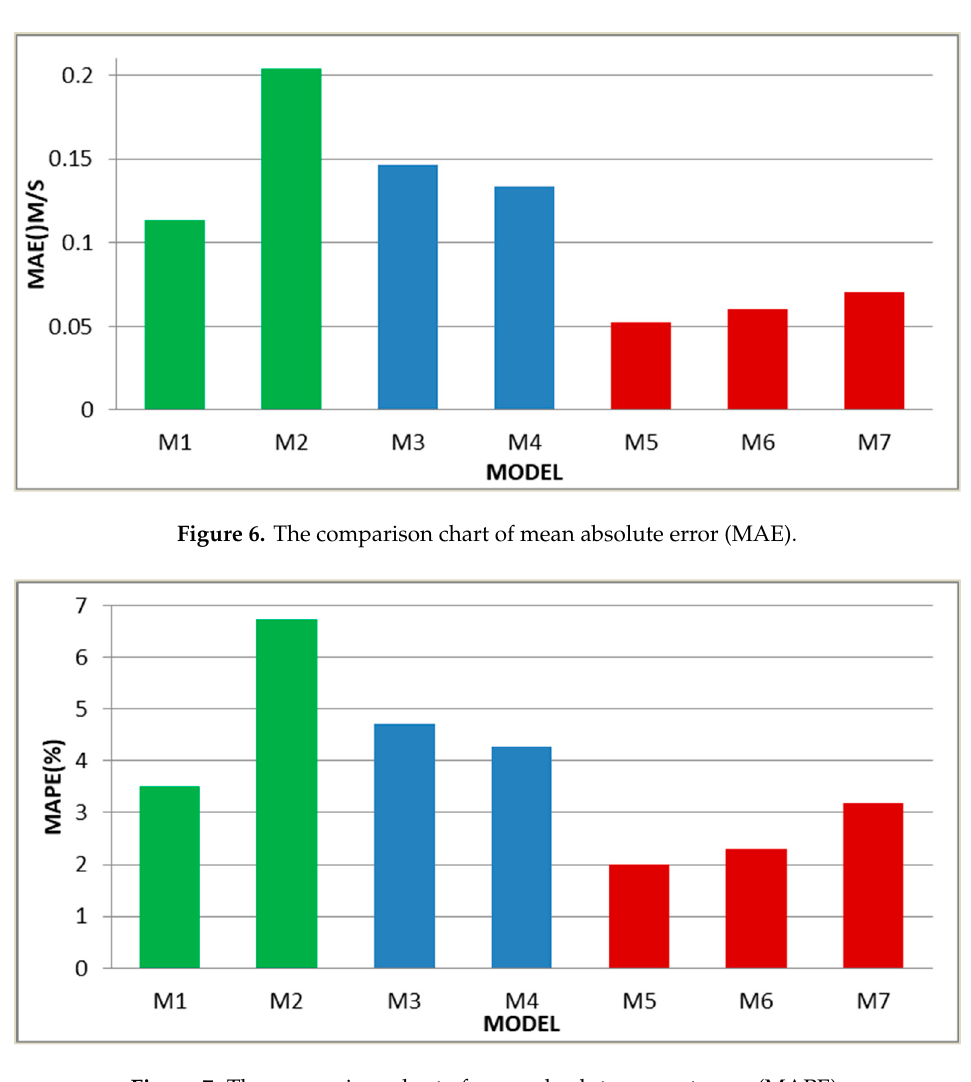
Figure 7. The comparison chart of mean absolute percent error (MAPE).